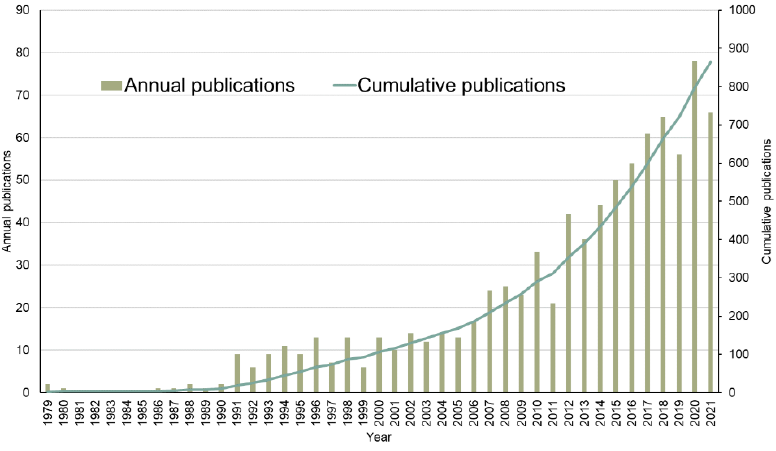
Table 3. Descriptive results.